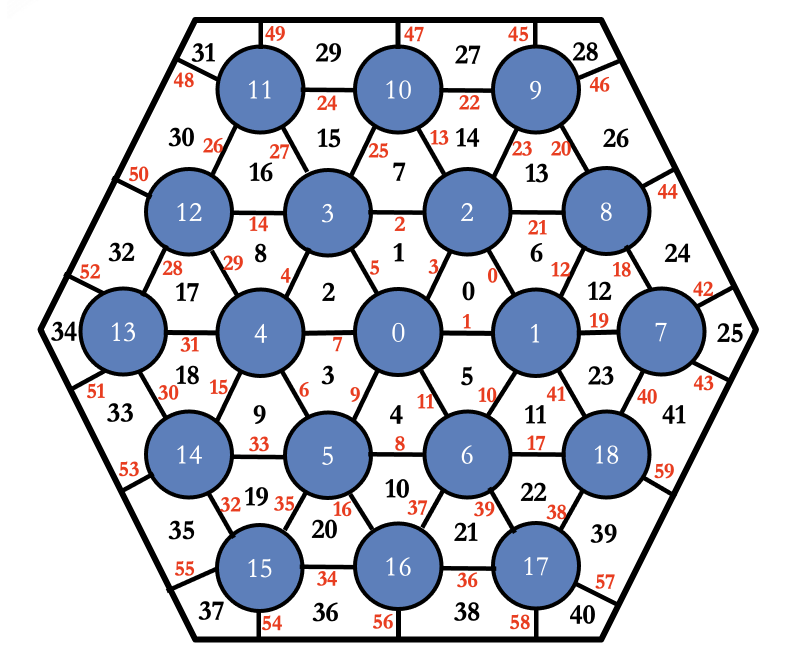
Figure 15. Pronghorn-SC model of THORS bundle and index notation (white: fuel pin index; black: subchannel index; red: gap